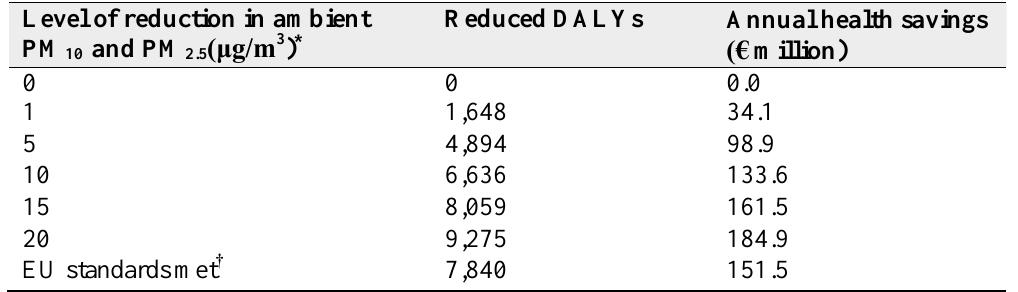
Table 3. The potential health ‘savings’ associated with reductions in PM (€ million) [Source: authors’